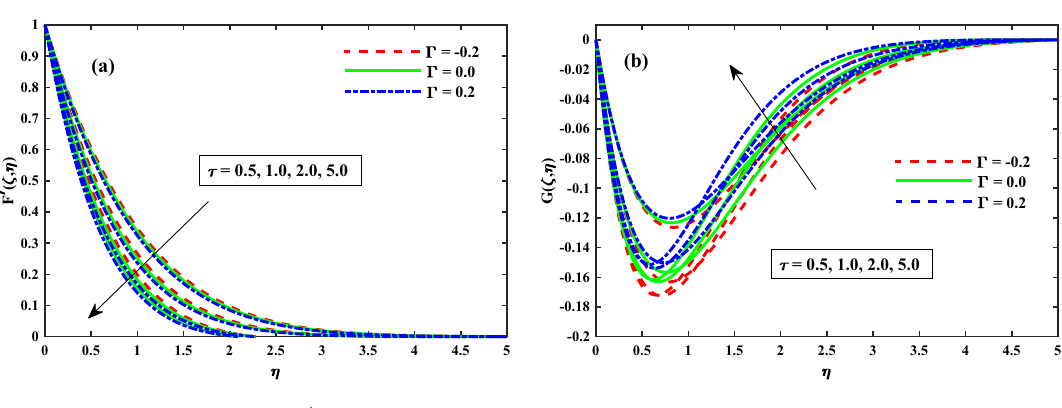
1 Figure 6. Impact of τ on F ′ (ζ , η) in x-direction, and G (ζ , η) in y-direction at ζ = Bogar nanofluid increases so at constant viscosity, Bogar fluid is highly elastic. Figure 4a,b displays that F ′ (ζ , η) and G ′ (ζ , η) for different values of magnetic field parameter. The existence of the resistive force in the form of Lorentz force is due to the inclusion of enhancing external magnetic field and leads to deceleration of the axial momentum in Fig. 4a while an opposite behavior is perceived for transverse momentum in Fig. 4b. The axial momentum F ′ (ζ , η) and Transverse momentum G ′ (ζ , η) for several values of rotation parameter portrayed in Fig. 5a,b respectively. It is witnessed from Fig. 5a that the declining of the axial momentum for growing values of rotation parameter due to Coriolis force whereas an opposed action is alleged for transverse momentum in Fig. 5b. For growing values of time-dependent parameter, the increase in the thickness of momentum bound- ary layer in the transverse direction and reduction of the thickness of the momentum boundary layer in the axial direction is depicted in Fig. 6a,b respectively. Thus, it confirms that the unsteadiness parameter is vital in controlling the momentum in the axial direction. Moreover from these graphs, it is perceived that the F ′ (ζ , η)